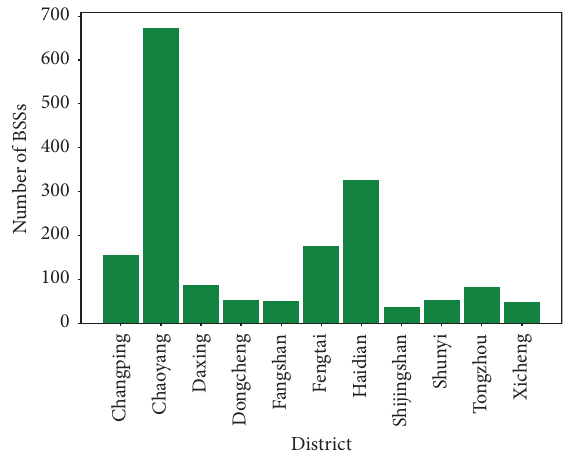
Figure 11: Te number of BSSs in each administrative district of Beijing.